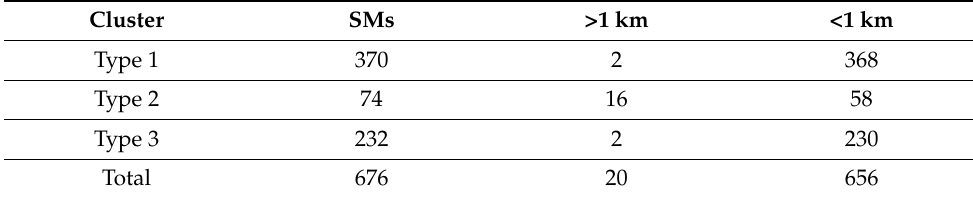
Table 3. Spatial analysis to identify SMs with at least 5 neighbours within 1 km.